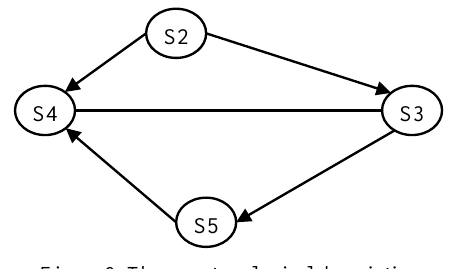
Figure 9. The new topological description